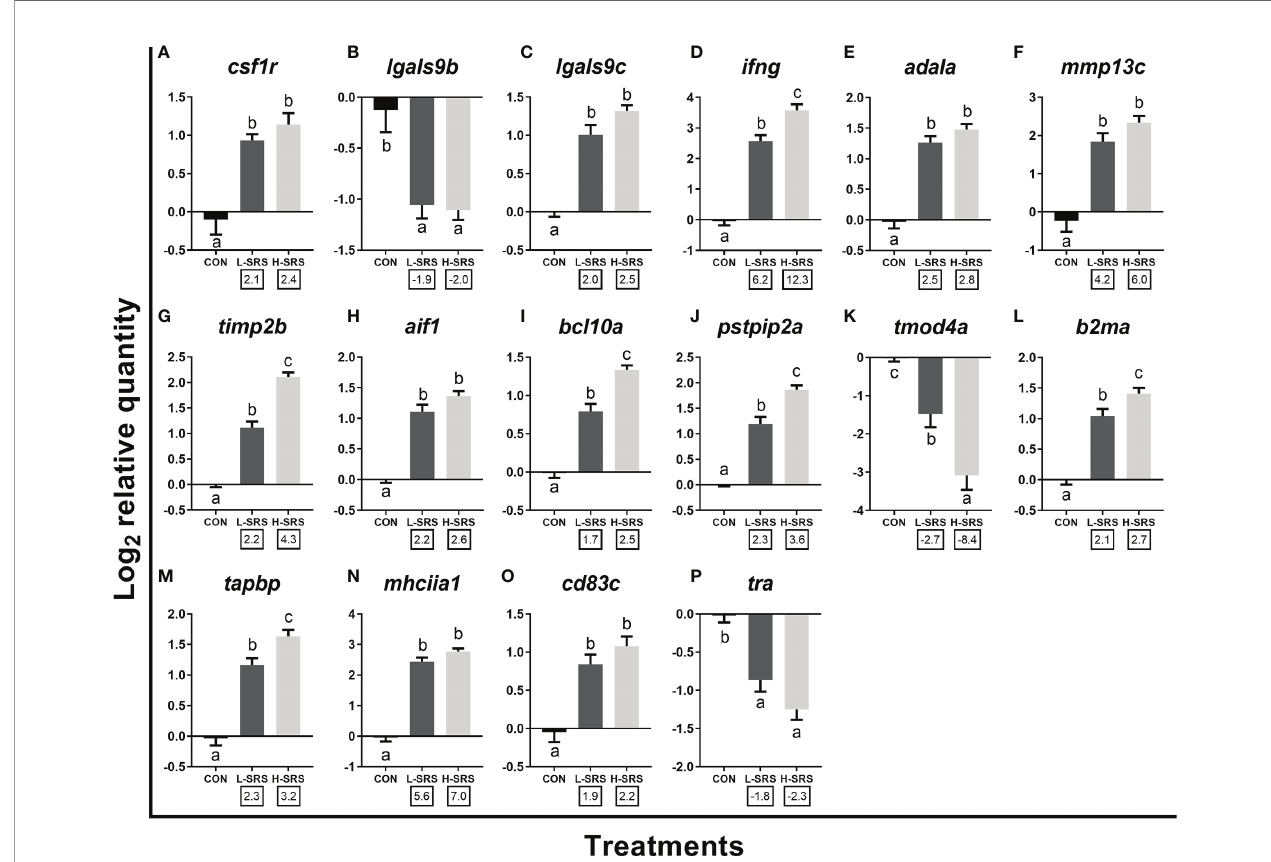
FIGURE 7 | qPCR analysis of P. salmonis -responsive genes involved in cellular immunity (e.g. leukocyte activation and function). Fish with lower (L-SRS; n = 11) and higher (H-SRS; n = 17) level of P. salmonis infection at 21 days post-injection (DPI) as well as time-matched control (CON; n = 9) were used for qPCR con fi rmation. Average log 2 RQs with SE bars are plotted. Different letters represent the signi fi cant differences among treatments ( p < 0.05) with fold-change relative to control indicated below the x-axis. For qPCR fold-change calculation, overall fold up-regulation was calculated as 2 A-B , where A is the mean of log 2 RQ from the L-SRS or H-SRS groups, and B is the mean of log 2 RQ from the CON group. For down-regulated transcripts, fold-change values were further inverted (-1/fold-change). (A) macrophage colony- stimulating factor 1 receptor ; (B) galectin 9b ; (C) galectin 9c ; (D) interferon gamma; (E) adenosine deaminase-like a ; (F) matrix metalloproteinase 13c ; (G) metalloproteinase inhibitor 2b ; (H) allograft in fl ammatory factor 1 ; (I) B-cell lymphoma/leukemia 10a ; (J) proline-serine-threonine phosphatase-interacting protein 2a ; (K) tropomodulin-4a ; (L) beta-2-microglobulin precursor a ; (M) tapasin ; (N) MHC class II antigen alpha chain 1 ; (O) cd83 antigen c ; (P) T cell receptor alpha